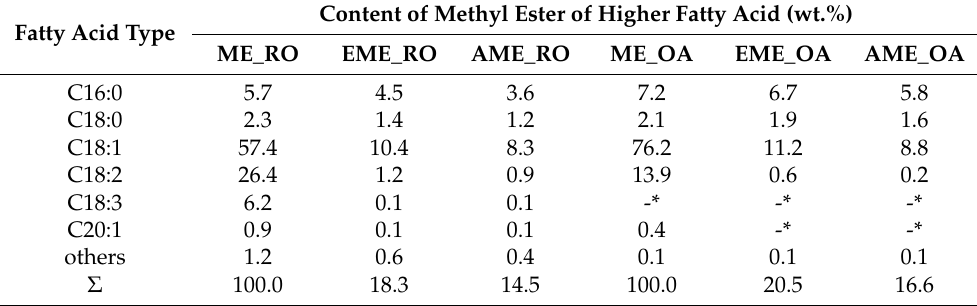
Table 2. Representation of non-epoxidized and non-acrylated methyl esters of different higher fatty acids in intermediate products, and final bio-based monomers originated from RO and OA.